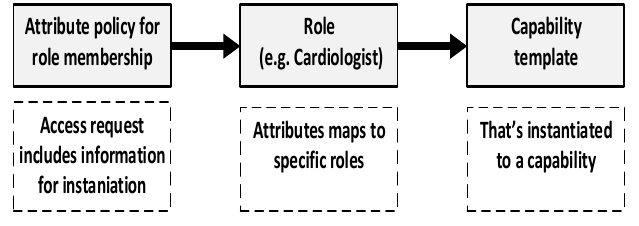
Figure 4. Use of attributesin capabilityinstantiation.